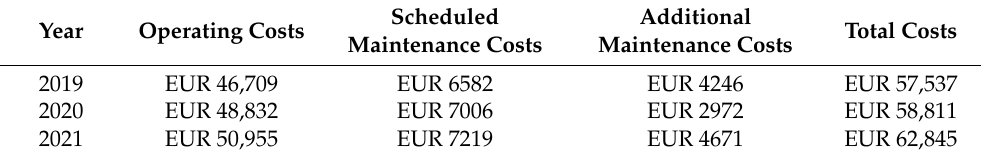
Table 2 summarises the costs of operating and maintaining the street lighting network. Table 2. Operation and maintenance costs of the street lighting network in a selected